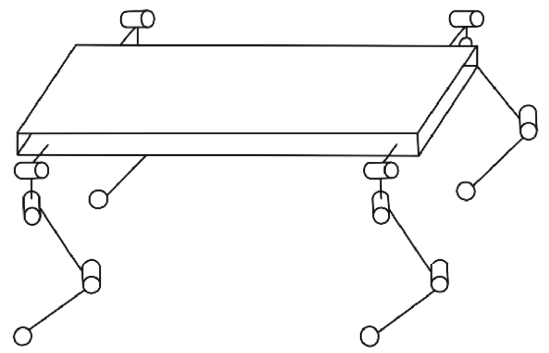
Figure 1: Quadruped robot based on serial leg